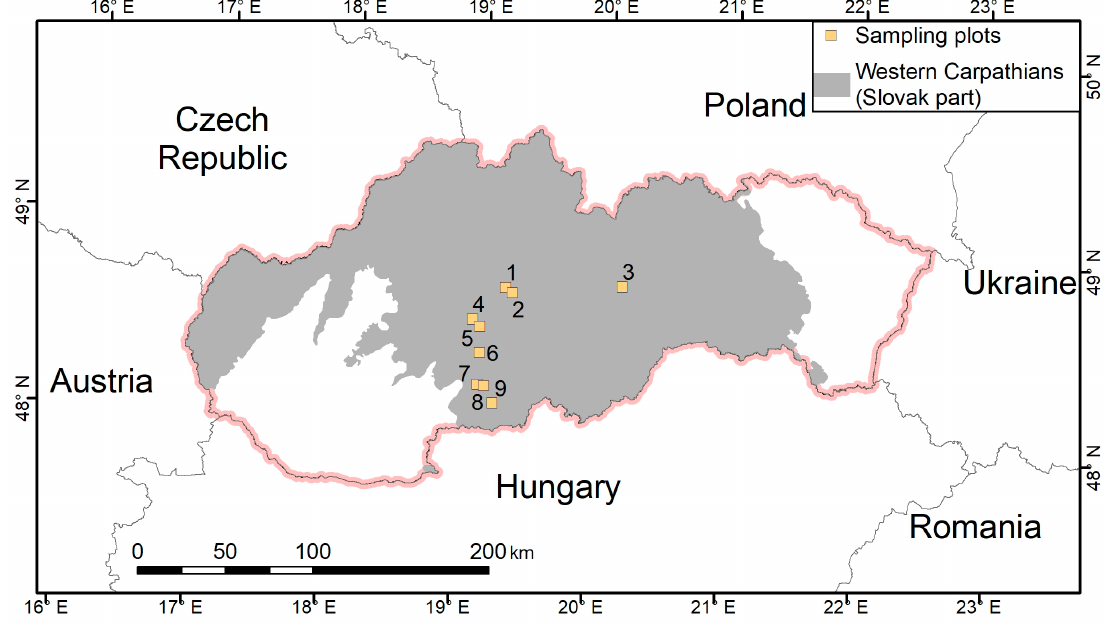
Figure 1. Localization of common aspen stands selected for biomass sampling (namely: 1—Podkonice I, 2—Podkonice II, 3—Telgart, 4—Kasova Lehota, 5—Straze, 6—Dobra Niva, 7—Suchan I, 8—Suchan II, 9—Opava).